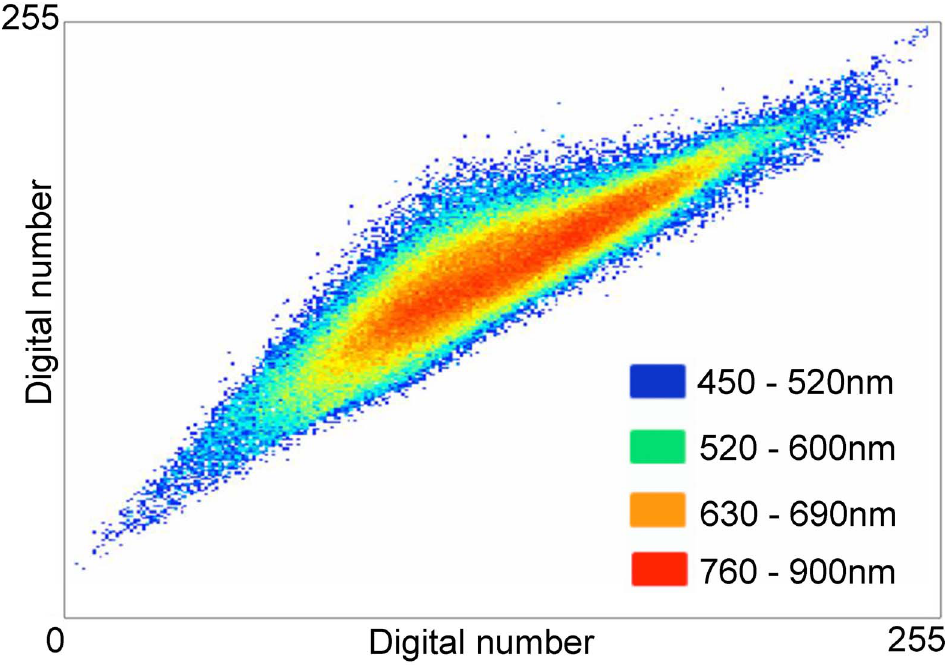
Figure 1. Spectrally decomposed signature of the S.damnosum s.l. larval riverine habitat pixel. The signature was extracted from 0.61 m 2 QuickBird satellite data, as described in the text. The figure depicts the wave band color reflectance ratio (i.e. pixel digital number) of the extracted spectral signature. Colors correspond to the bandwidths indicated in the figure.